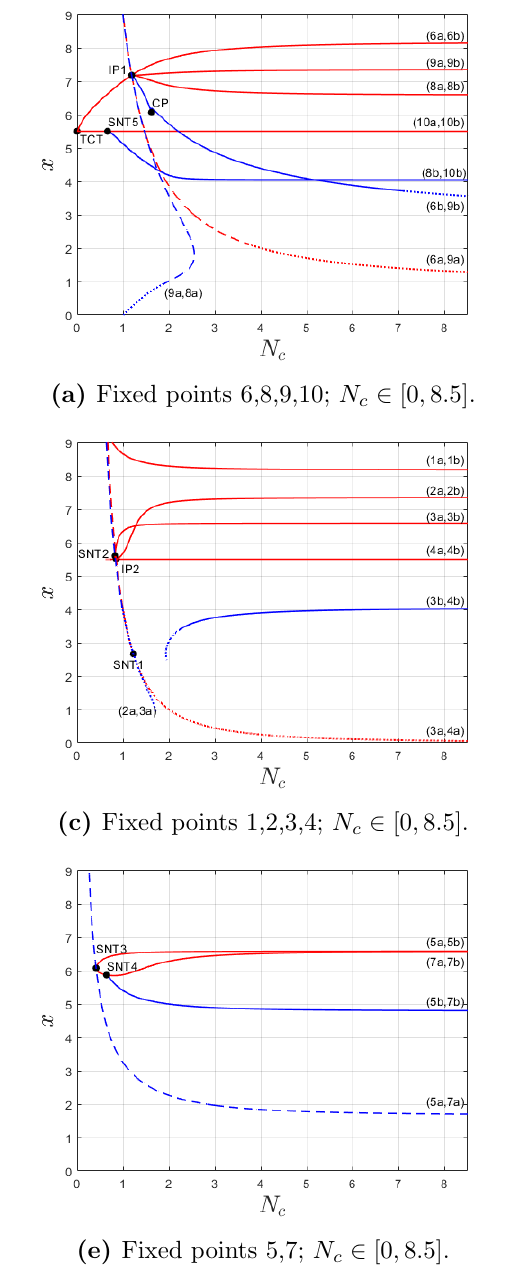
Figure 7. Bifurcations of various sets of (cid:12)xed points in the QCD 4 model (2.7) in the ( N c ; x )- plane. CP: Cusp bifurcation. SNT: Saddle-Node-Transcritical bifurcation. TCT: Transcritical- Transcritical bifurcation. IP: degenerate bifurcation point. Numbers indicate which equilibria are involved in the bifurcation, and correspond to the numbers in (cid:12)gure 6.